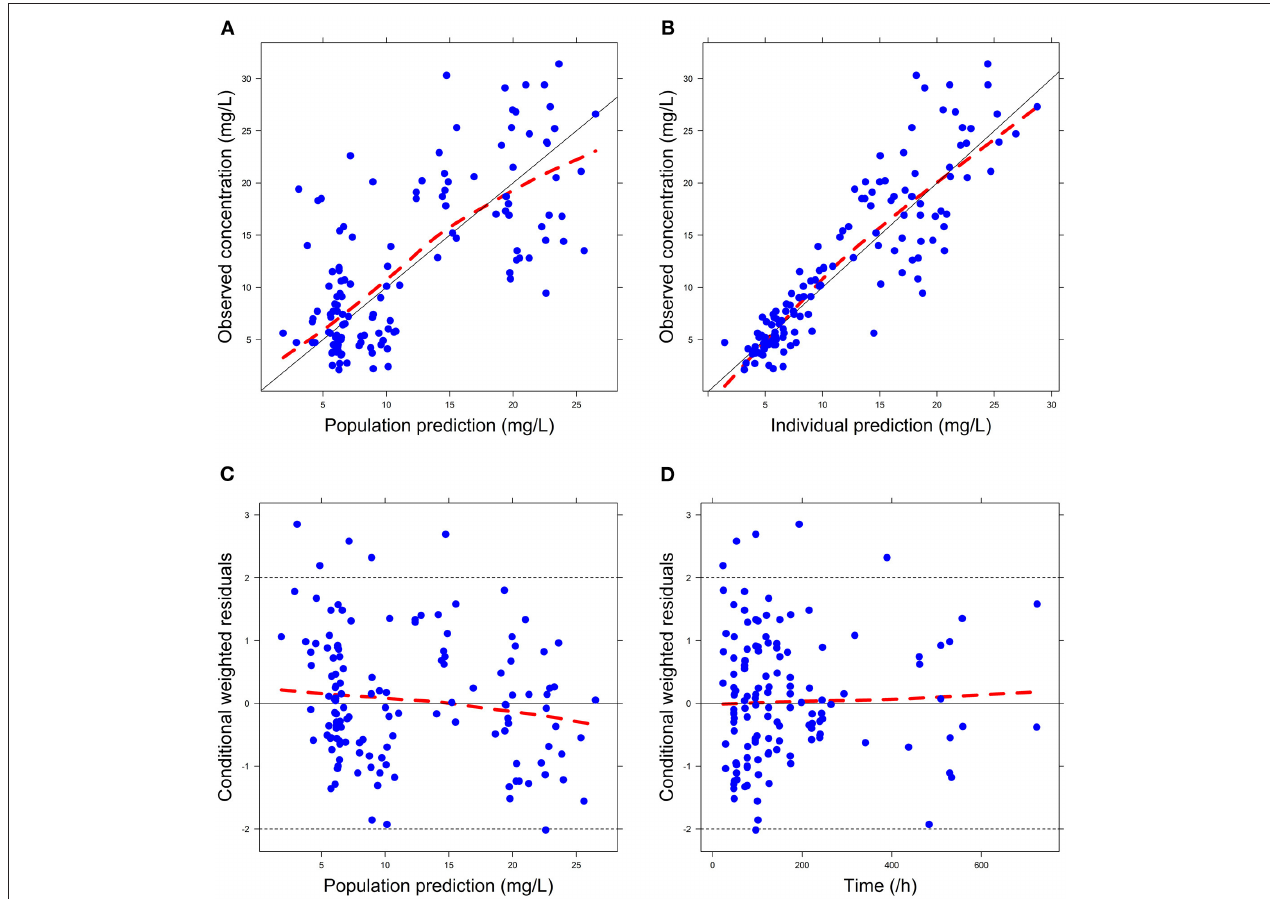
FIGURE 2 | Goodness-of-fit (GOF) plots of Model 2: (A) observed concentration (DV) vs. population prediction (PRED); (B) DV vs. individual prediction (IPRED); (C) conditional weighted residual errors (CWRES) vs. PRED; (D) CWRES vs.